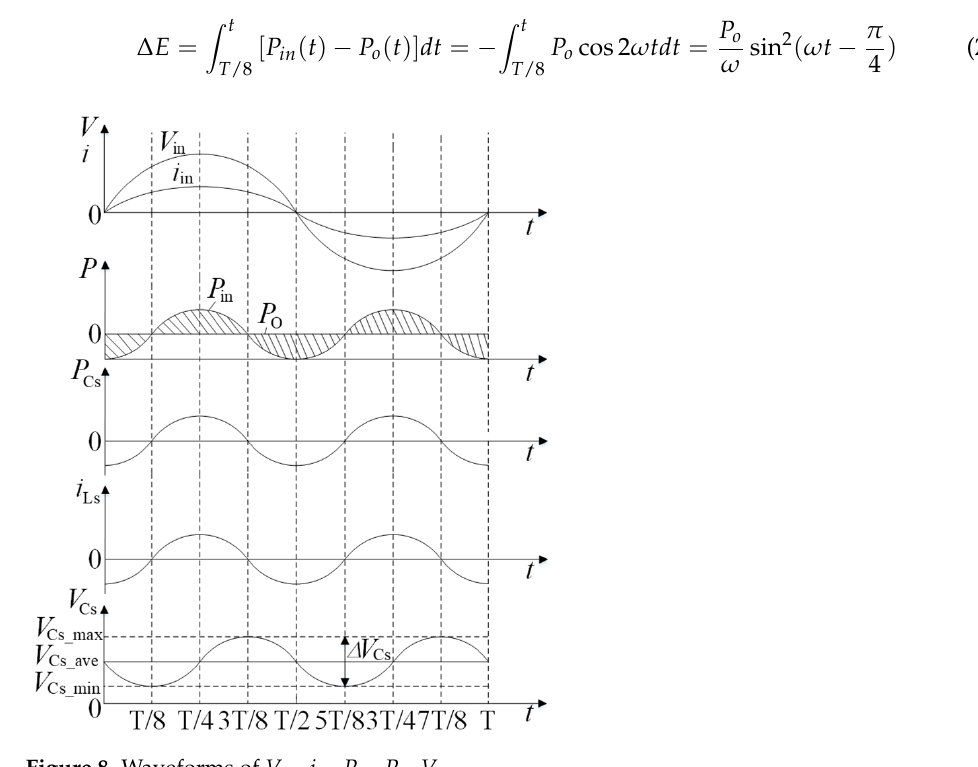
Figure 8. Waveforms of V in 、 i in 、 P in 、 P o 、 V cs .